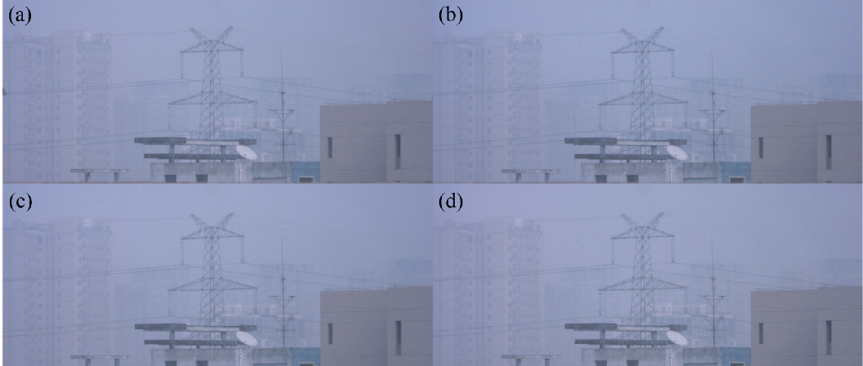
Figure 5. Original captured images in different hazy weather. ( a – d ) represent the raw hazy images with the polarized orientation of 0 ° , 45 ° , 90 ° and 135 ° , respectively.